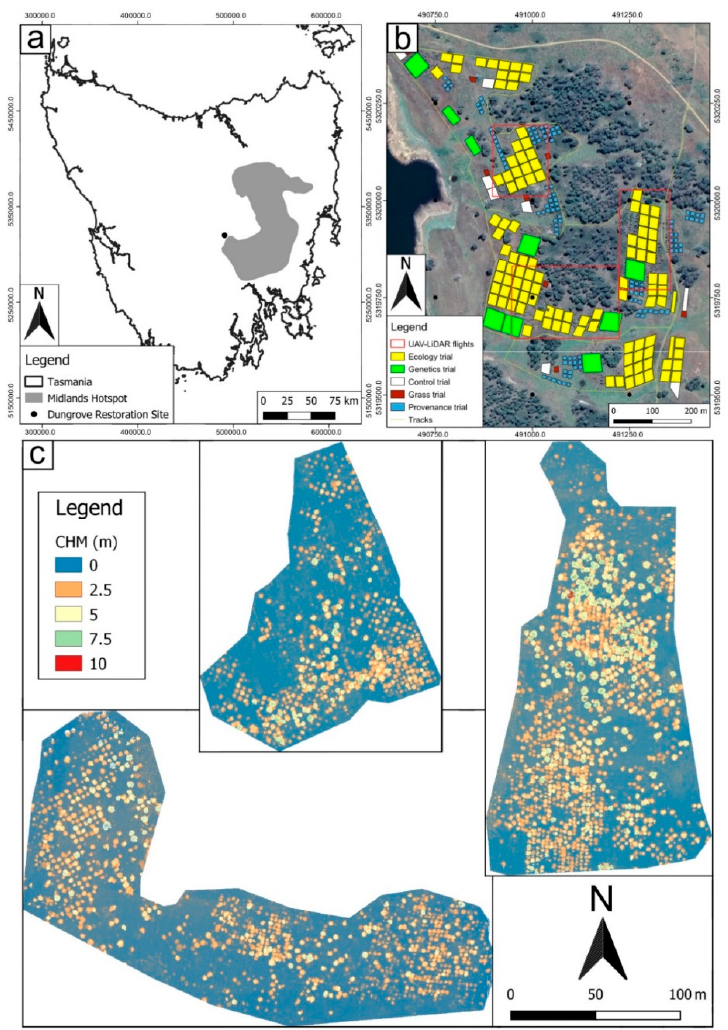
Figure 1. Location of the restoration common-garden restoration trial site at Dungrove (black dot) relative to the Midlands biodiversity hotspot (grey surface) of the south-east island of Tasmania, Australia (Panel ( a )). Panel b shows the layout of the various experiments established at the trail site, including the ecology trials represented by the yellow blocks. Also shown in Panel ( b ) are the